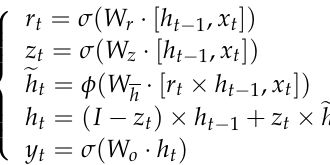
Figure 4. Comparison of CNN and TCN convolution. The receptive field can be written as: max s R k d s = (7) For 1D sequence input X and filter